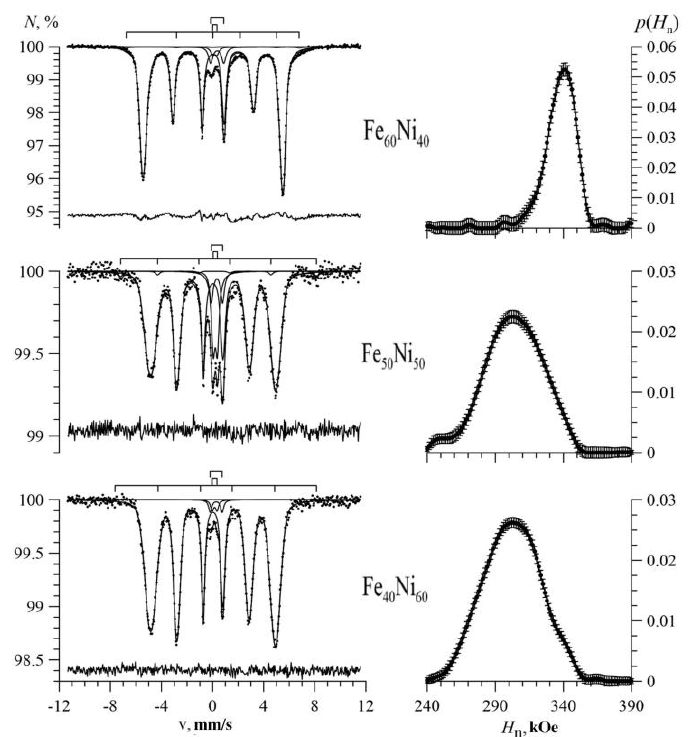
Figure 5. Mössbauer spectra (left) and the result of reconstructing the distribution of the hyperfine magnetic field (right) of Fe 100-x Ni x nanotubes at x = 40%; 50%; 60%.